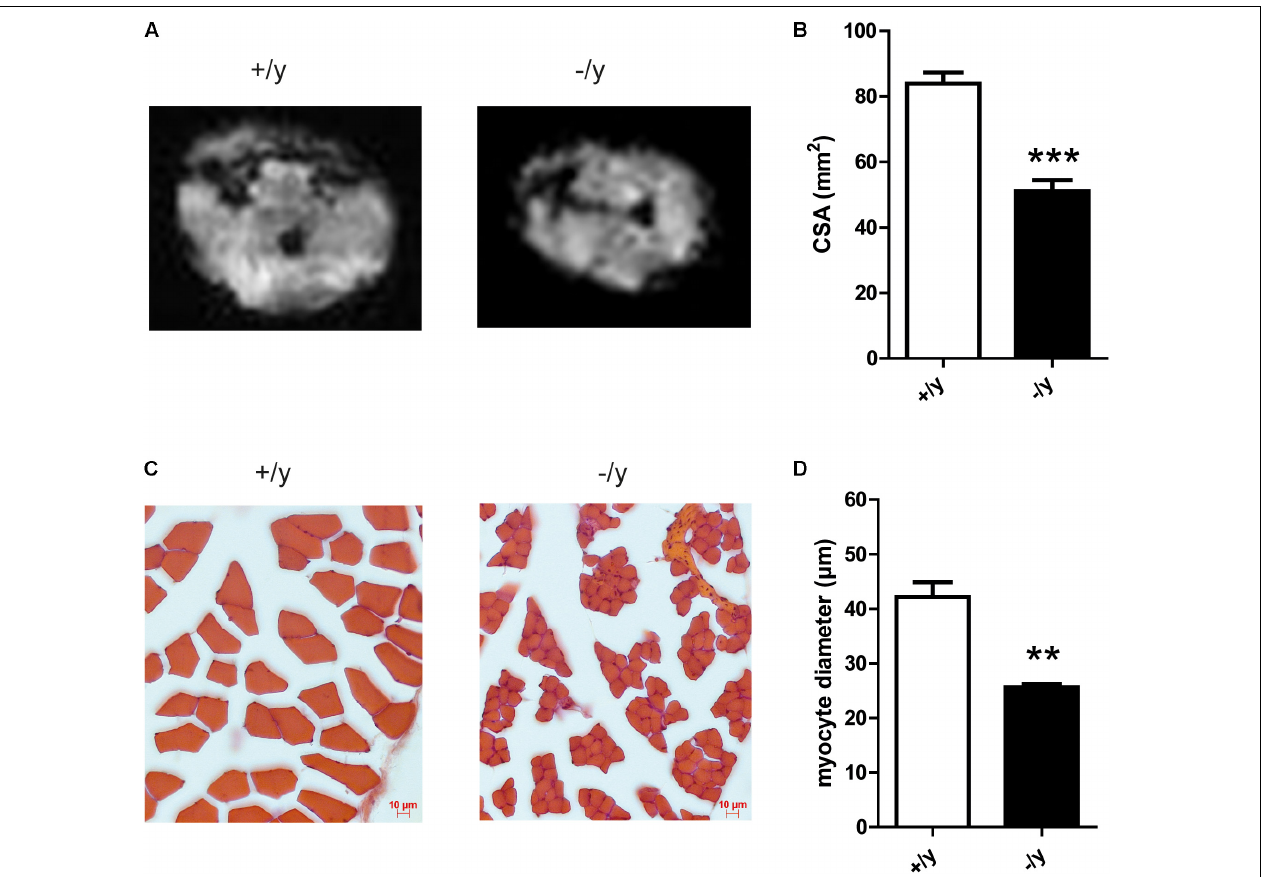
FIGURE 5 | Muscle morphology and histology of CT1-deficient mice. (A) MR images for gross morphological analysis of hind limb muscles. (B) Cross-sectional area of hind limb muscle ( n = 4–5, ∗∗∗ P < 0.001) determined by MRI. (C) Representative histological staining of extensor digitorum longus muscle. (D) Myocyte diameter of extensor digitorum longus muscle ( n = 3, ∗∗ P <